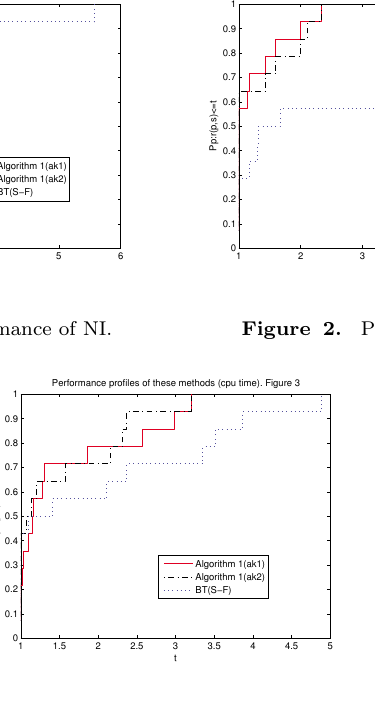
Figure 3. Performance of cpu